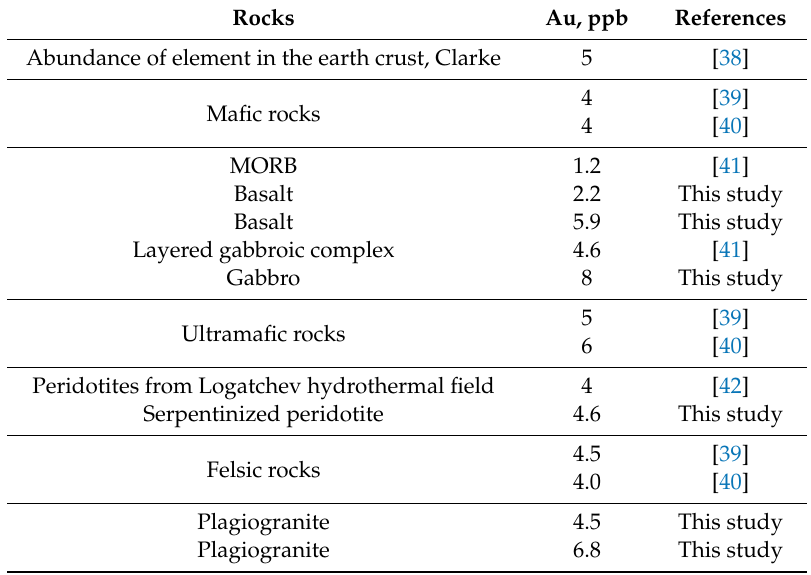
Table 11. Gold content of Semyenov-2 host rocks in comparison with di ff erent data. Rocks Au, ppb Abundance of element in the earth crust,